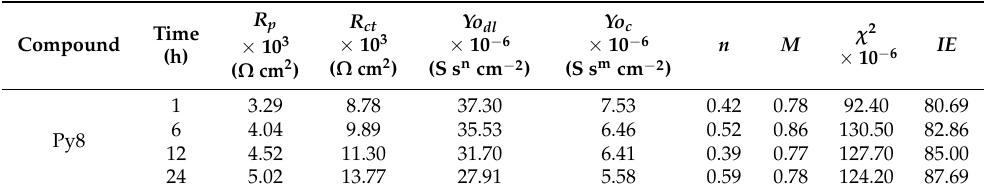
Table 5. EIS parameters for for EN3B mild steel immersed in 3.5% NaCl solution (pH 1.5) in the presence of 10 mM Py8 at different immersion